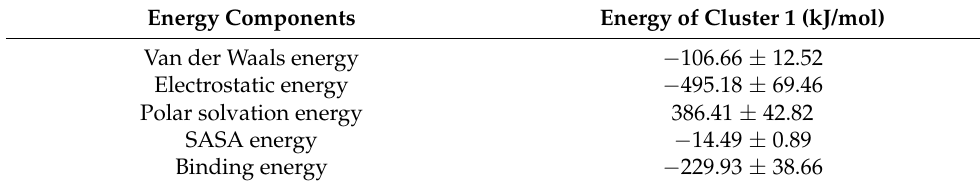
Table 3. Energy components of the MGAM-TW complex.